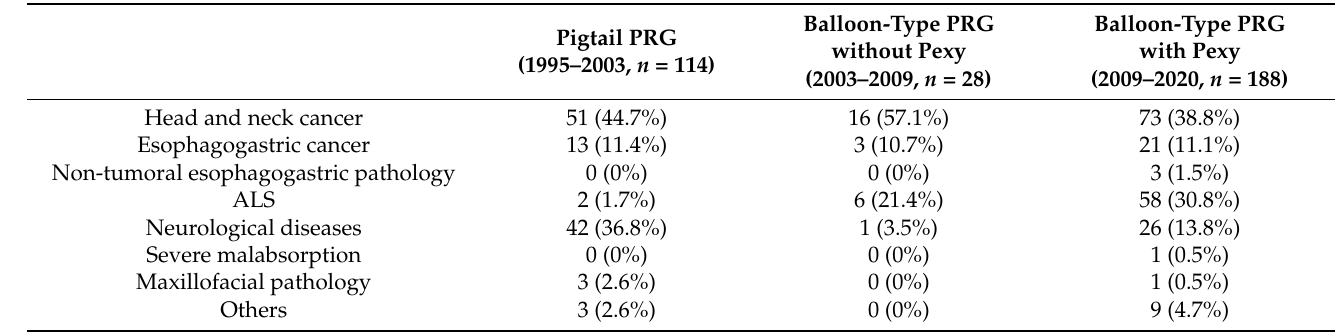
Table 2. Indication of PRG in 330 patients seen in the nutrition unit of the Virgen del Roc í o University Hospital between 1995 and 2020.